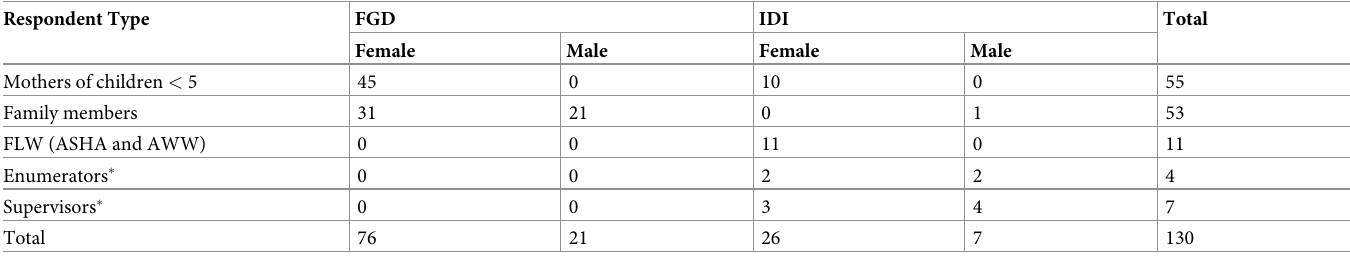
Table 1. Sample size by type of participant and interview